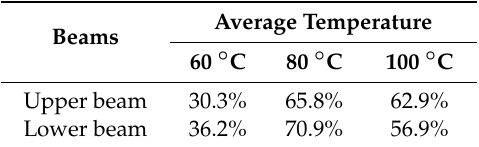
Table 3. Healing ratios of the samples at different microwave heating temperatures.